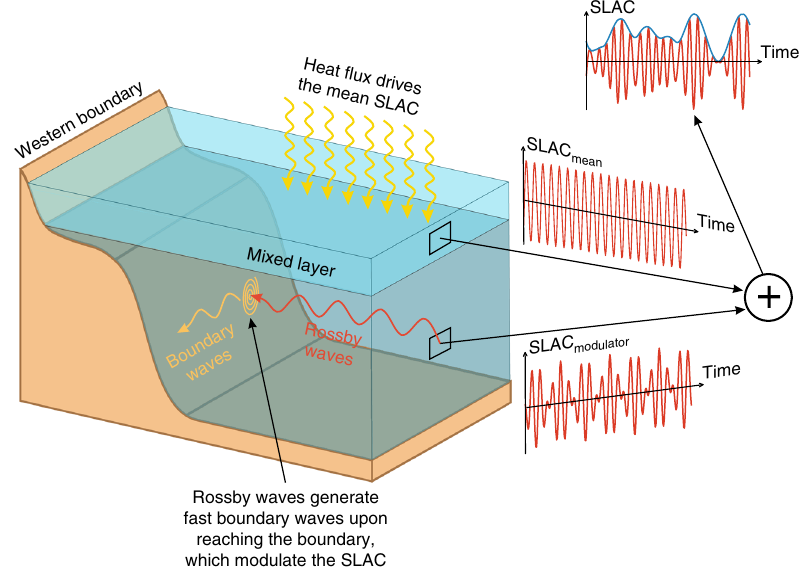
Fig. 8 Schematic illustration of the mechanism of SLAC modulation. The mean SLAC is associated with steric changes in the seasonal thermocline induced by variations in surface heat fl uxes, whereas its modulation is related to density anomalies in deeper layers propagating westward as Rossby waves. These Rossby waves give rise to fast boundary waves upon impinging on the western boundary, which in turn modulate the SLAC along the Gulf and Southeast coasts and lead to the coherence over large distances along the coast